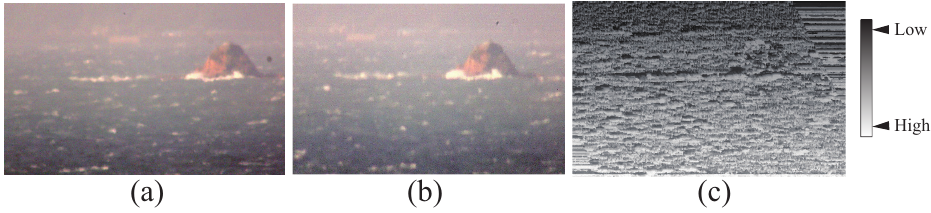
Figure 15. Dense matching results: ( a , b ) are the left and right images and ( c ) is the disparity map of ( a , b